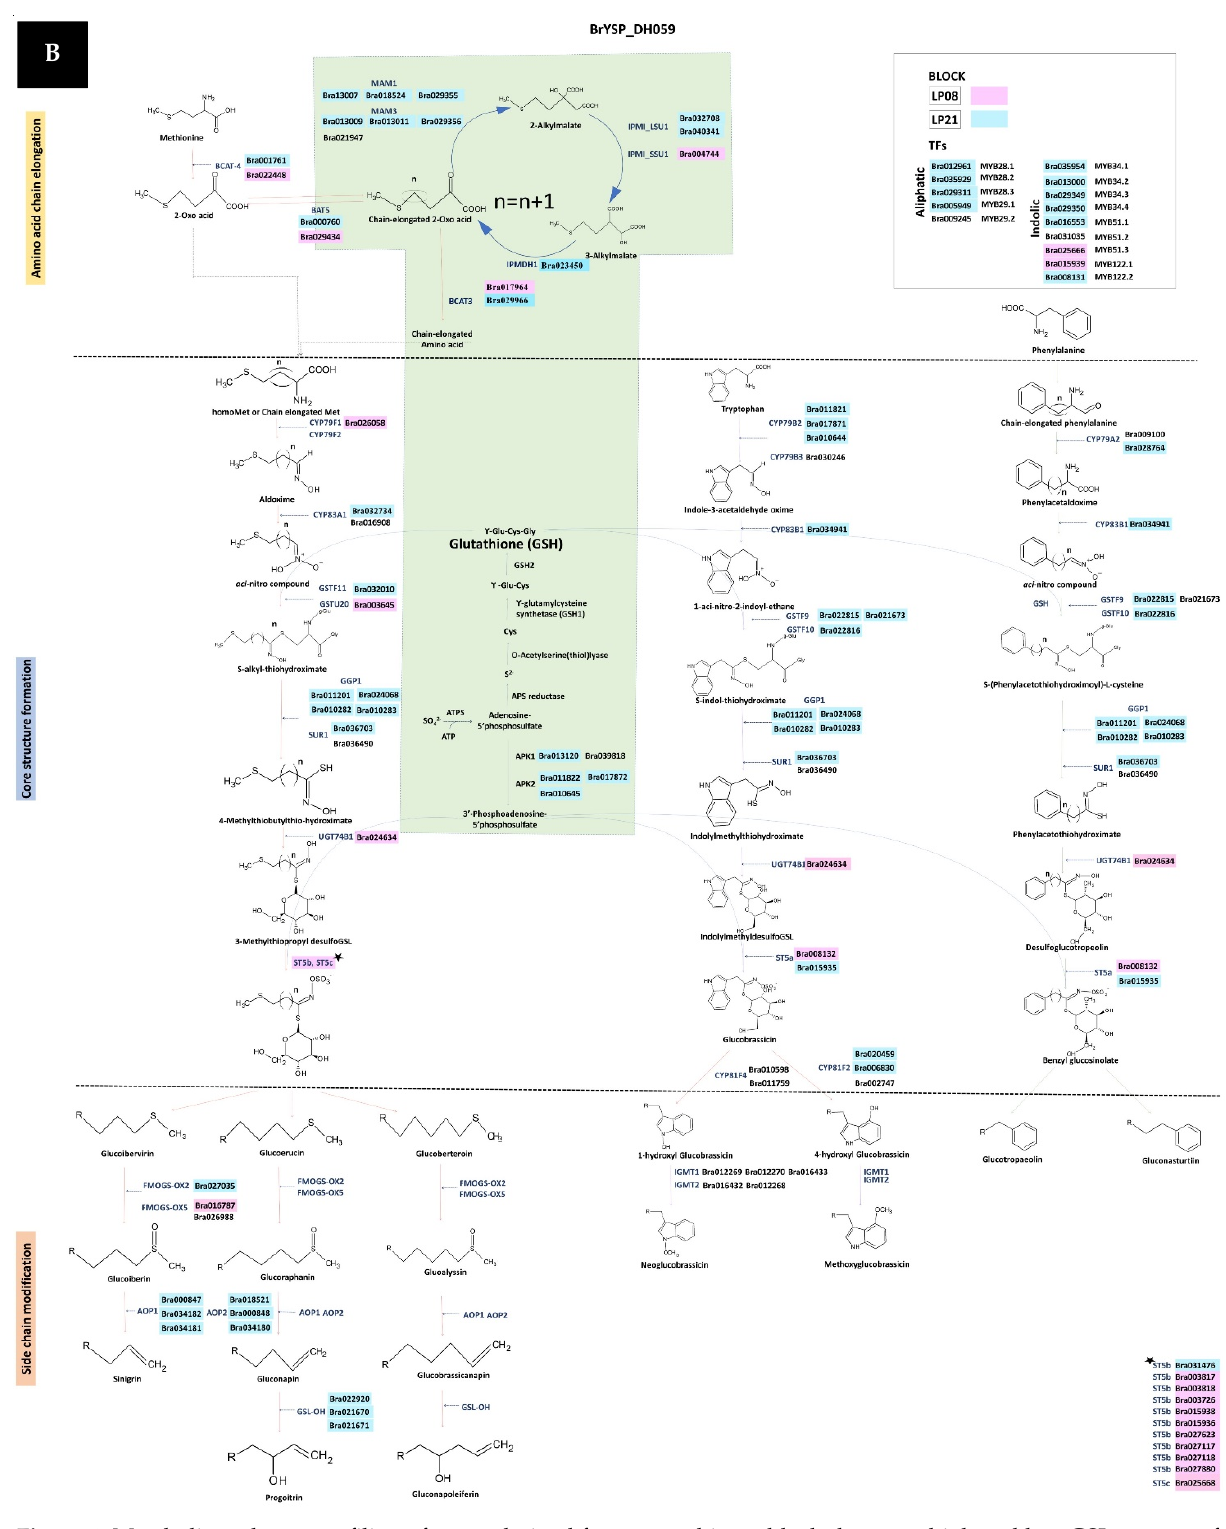
Figure 4. Metabolic pathway profiling of genes derived from recombinant blocks between high and low GSL parents of doubled haploid lines BrYSP_DH005 ( A ) and BrYSP_DH059 ( B ). The pathway and product structures are adapted from previously published reports [6,18,21,37] and the Brassica database BRAD. Genes not identified in recombinant blocks are not highlighted. Structure of all products were drawn using ChemSketch software.